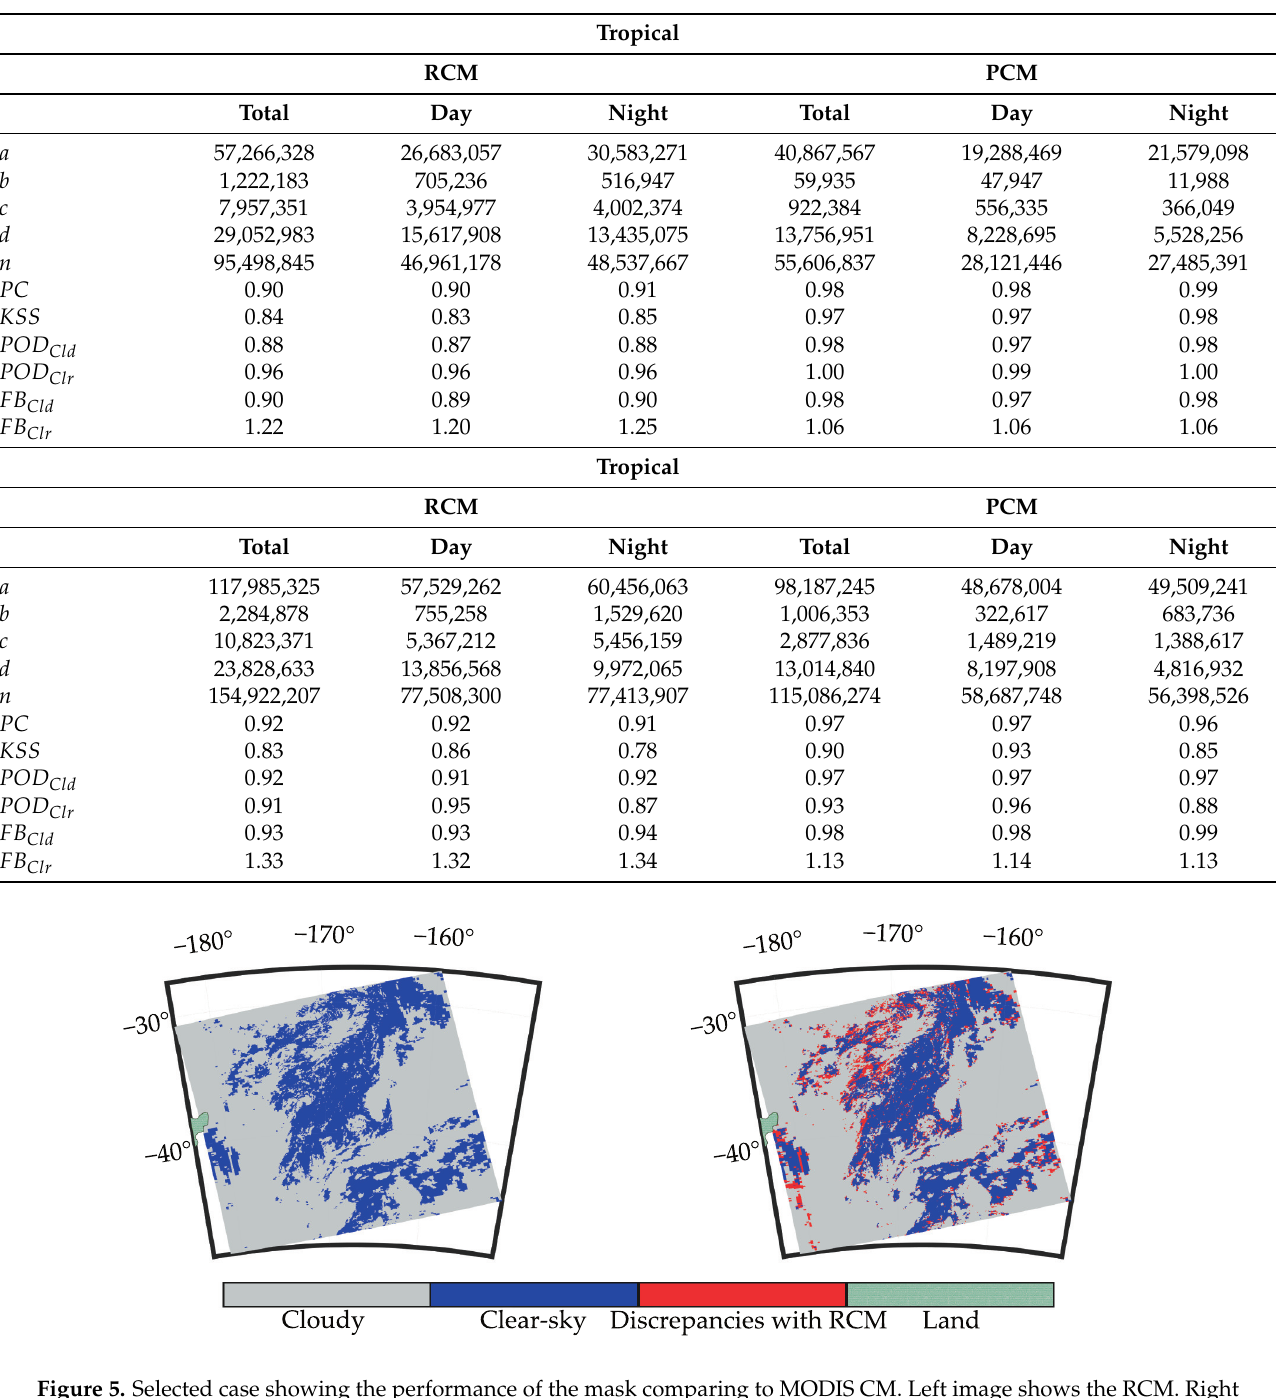
Table 5. Skills scores of the SWCM compared against the PC and RCM during day and night-time, including tropical and midlatitude.